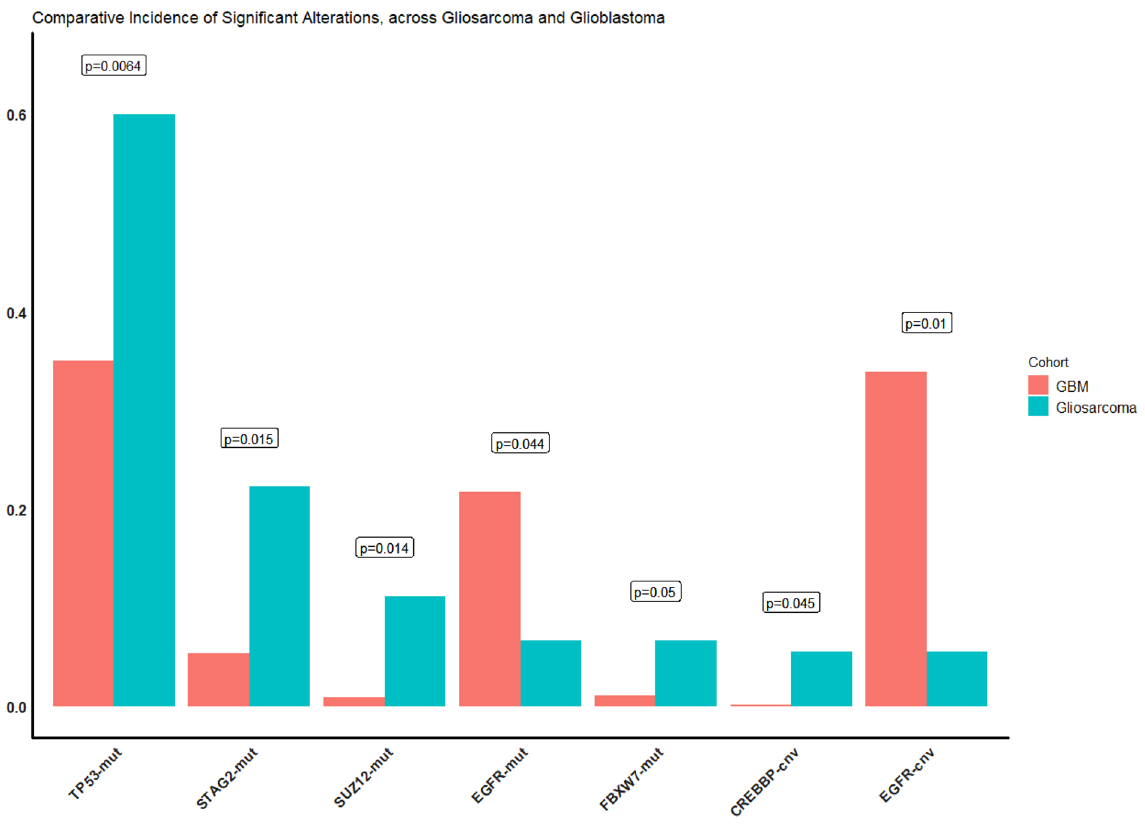
Figure 3. Comparative incidence of common alterations between GBM and gliosarcoma. Incidence of alterations which significantly differed between gliosarcoma and GBM (Fisher’s Exact Test p < 0.05), although no differences retained significance after multiple hypothesis